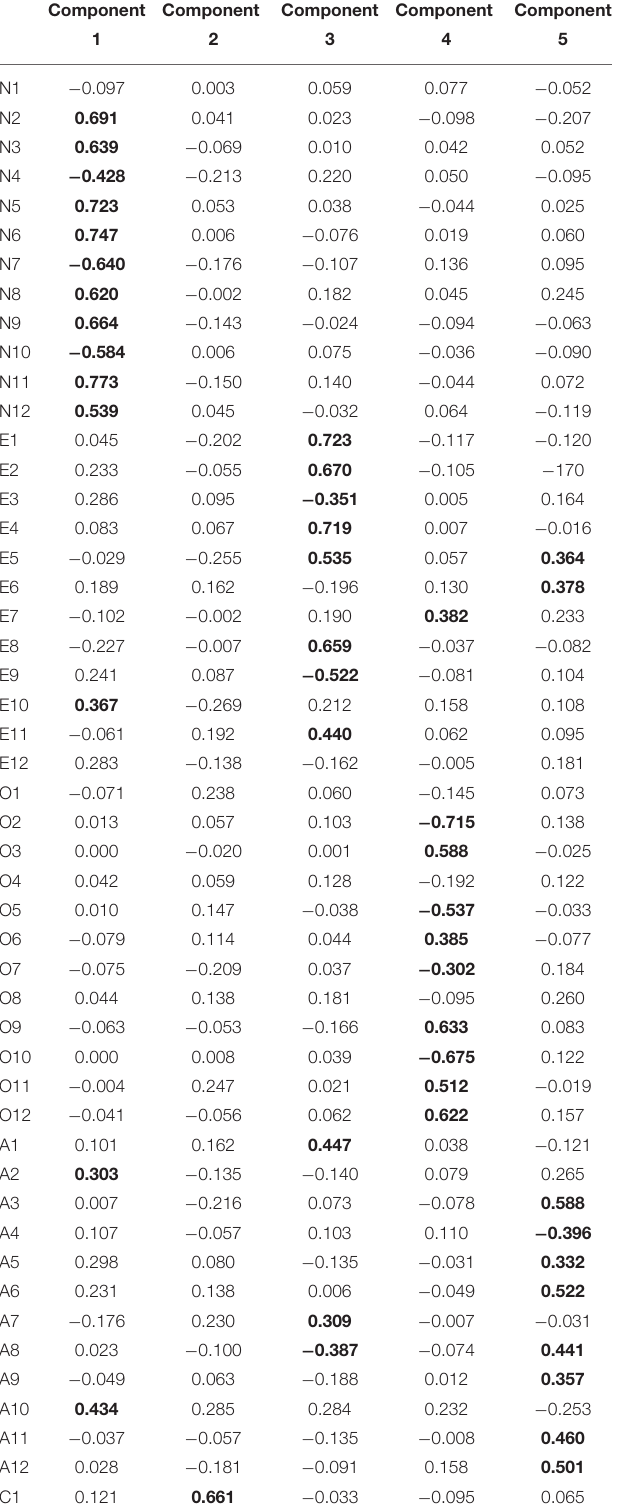
TABLE 7 | Component-analysis of the first five (oblique) promax factors extracted from analysis of the NEO-FFI ( n = 378). Component Component Component Component Component